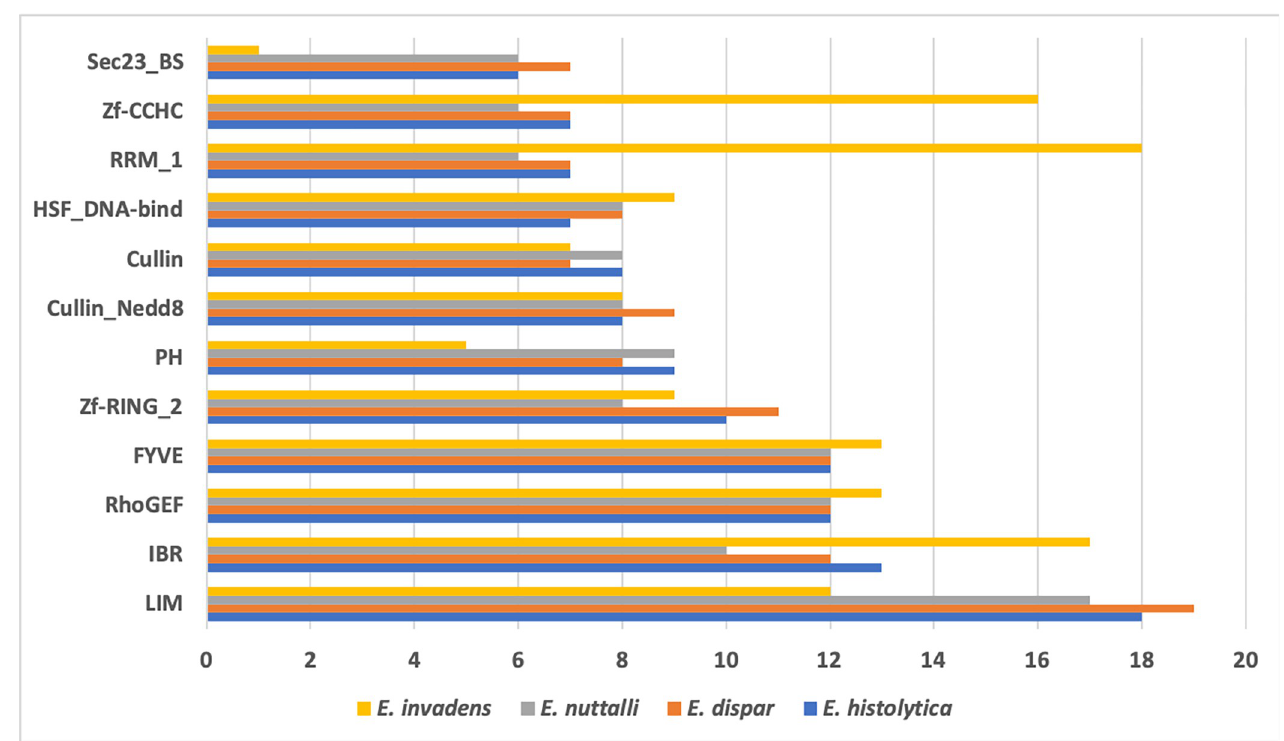
Fig 3. The most abundant families in Entamoeba strains. On the X-axis is the number of proteins; the Y-axis indicates the TF family